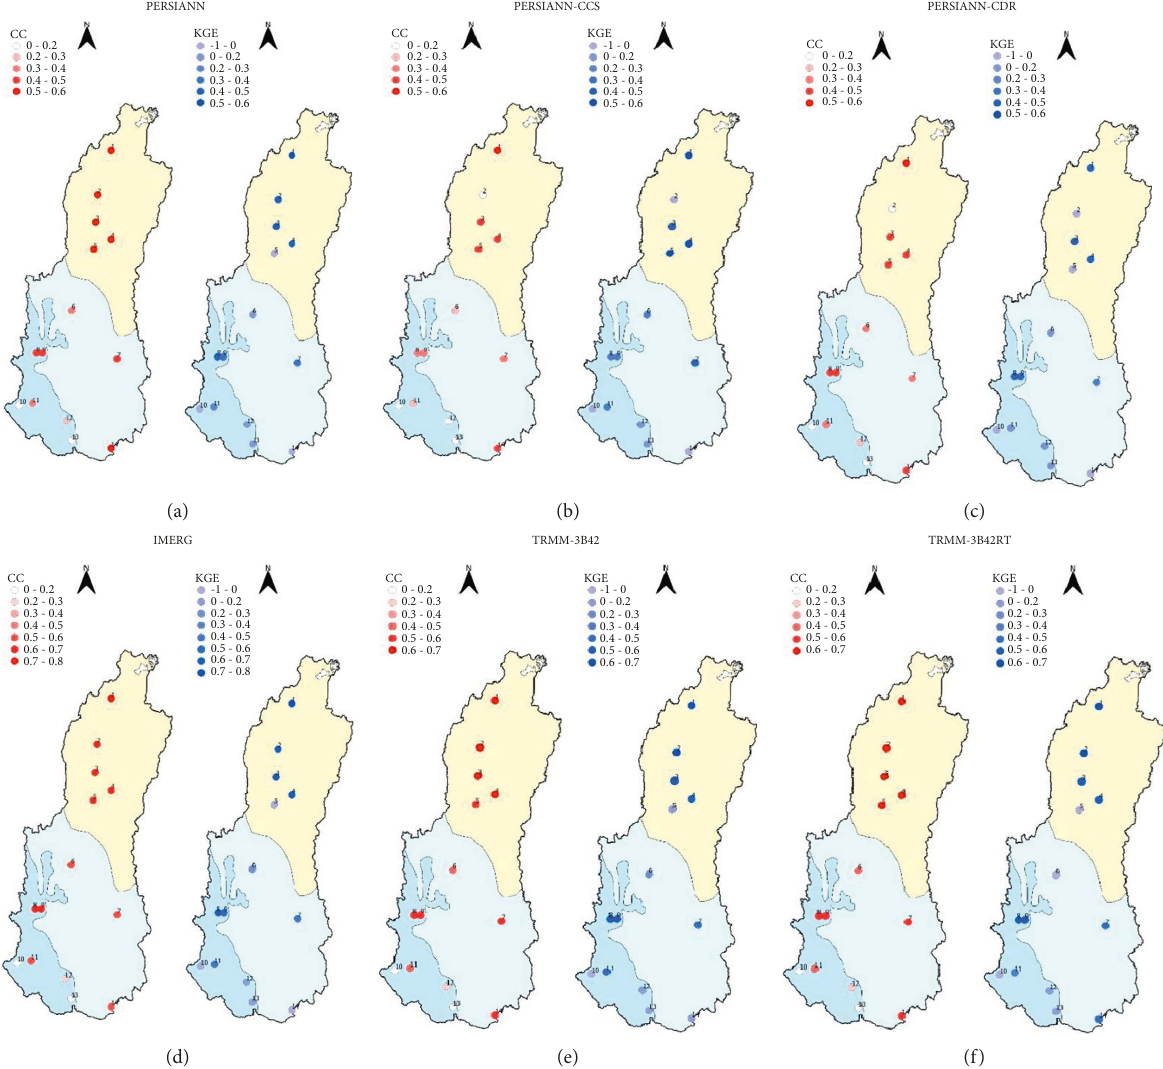
Figure 5: CC and KGE results for daily time scale. (a) For PERSIANN. (b) For PERSIANN-CCS. (c) For PERSIANN-CDR. (d) For IMERG. (e) For TRMM-3B42. (f) For